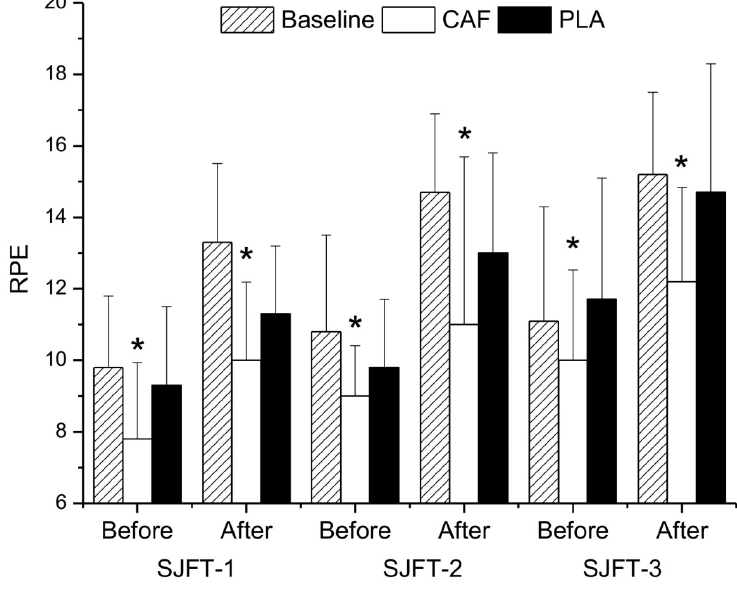
Figure 3. Rating of perceived exertion (RPE) before and after each bout of SJFT in control and after a 5-day weight loss period followed by caffeine (CAF) or placebo (PLA). Data are expressed as the mean ± SD. * Significantly lower than control and PLA